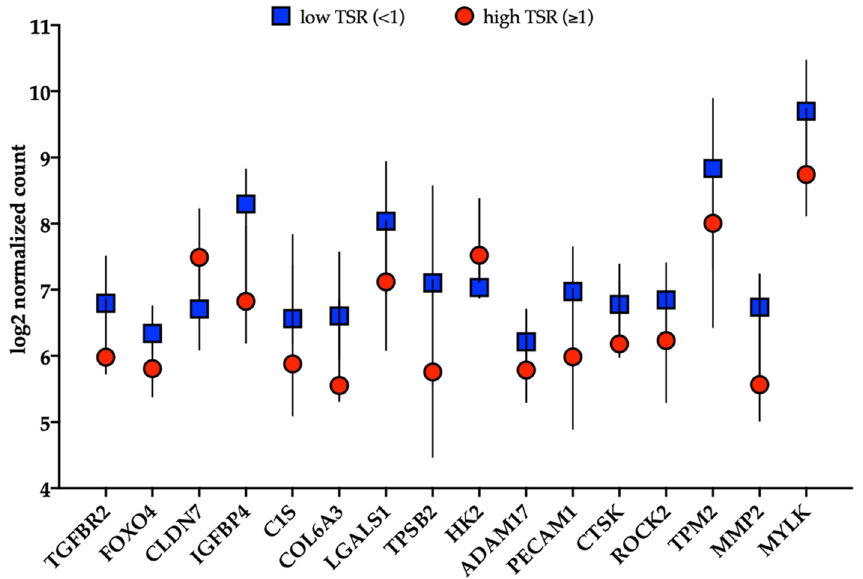
Figure 5. Genes diversly expressed in relation to the TSR score. Statistical significance was consid- ered at p -value ≤ 0.05, n = 42. at p -value ≤ 0.05, n =